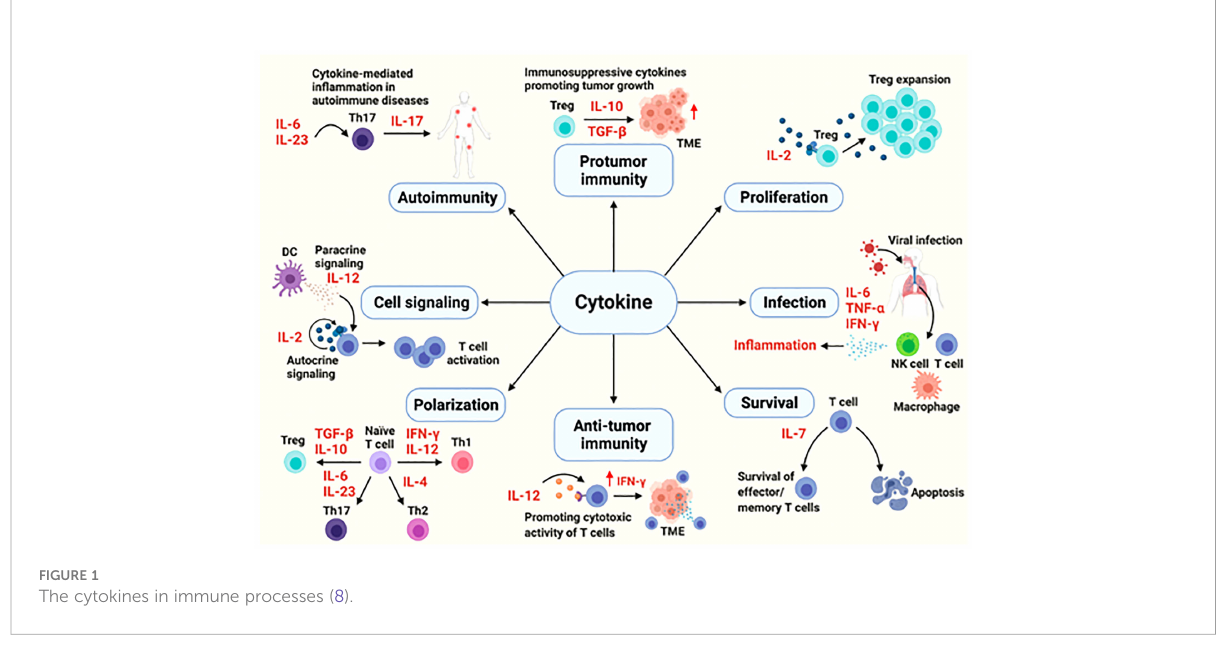
FIGURE 1 The cytokines in immune processes